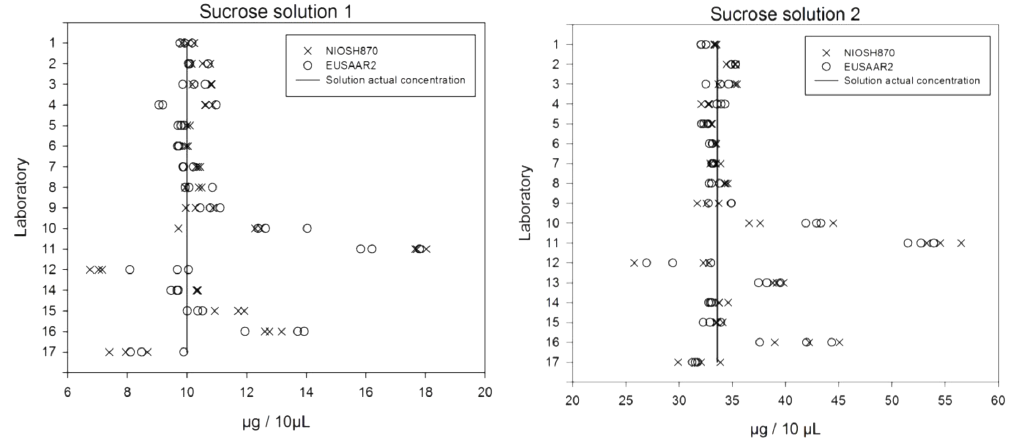
Figure 1. Triplicate sucrose solution analysis (S1 and S2) per protocol and participant. S1 and S2 concentrations of 10.0 and 33.6µg10µL − 1 ,